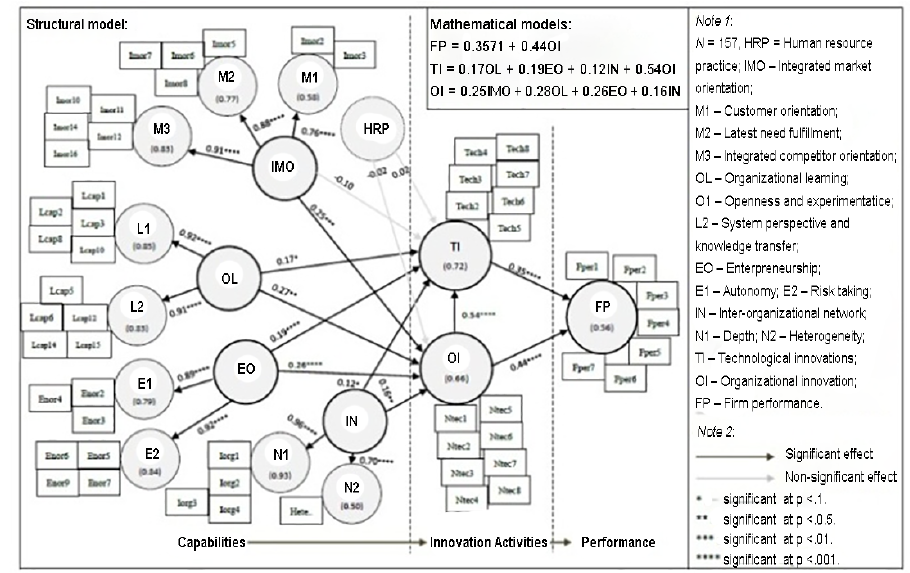
Figure 2. Final capability-based forecasting approaches for innovation development in